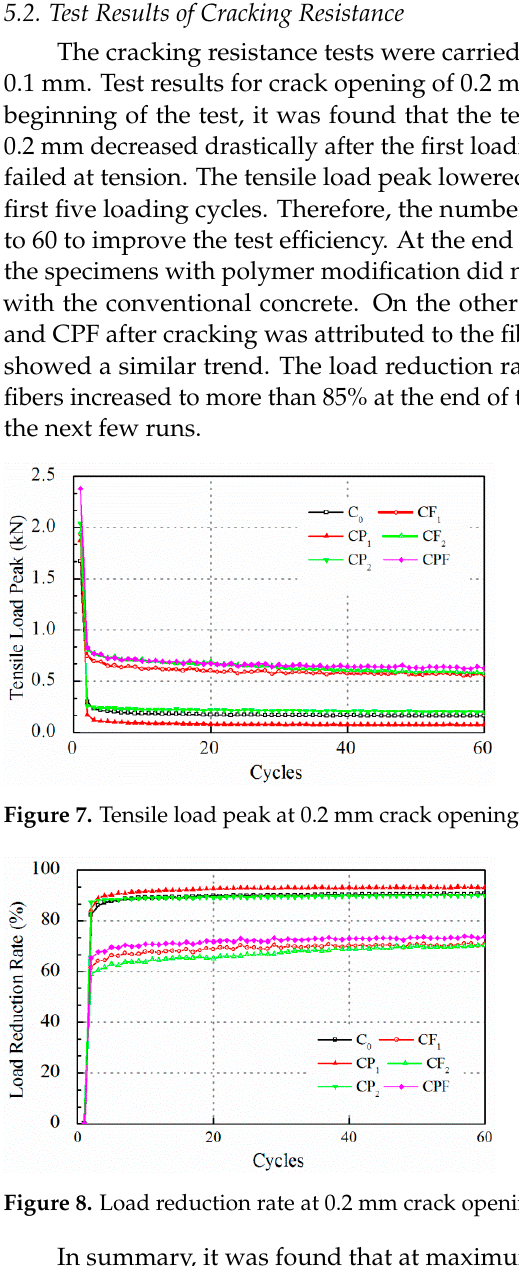
Figure 6. Strength test results. ( a ) Compressive strength; ( b ) Flexural strength.